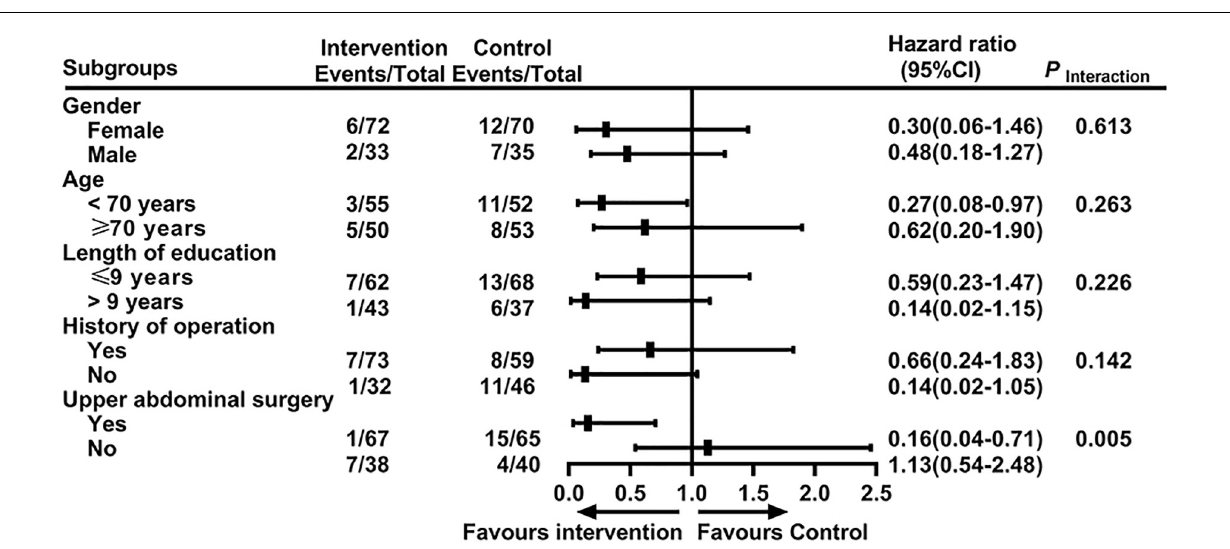
FIGURE 3 | Forest plot of the subgroup analysis for the primary